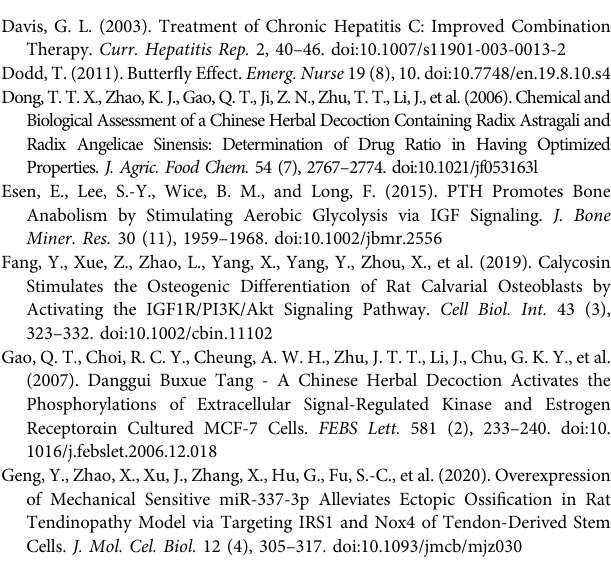
Supplementary Figure 1 | Chemical analysis of DBT and DBT Δ cal. (A): Chemical structure of calycosin. (B): Calycosin at different amount was applied onto osteoblast for 7 days to analyze cell proliferation, ALP activity and pRUNX2-Luc response. These parameters were compared between calycosin and vehicle control. (C) One hundred mg/mL of herbal extract was subjected to analysis, detected at the wavelength 254 nm. The isolated fraction was shown. (D) : ELSD analysis of DBT and DBT Δ cal. Typical HPLC fi ngerprint of DBT and DBT Δ cal were shownhere.Onehundredmg/mLofDBTandDBT Δ cal wasloadedtoHPLCcolumn, and the chemical fi ngerprint was revealed at the ELSD and DAD detector. The isolated fraction was shown. Representative chromatograms were shown, n (cid:2) 4. (E) : Quantitative assessment of 5 major chemicals in DBT and DBT Δ cal. Values are expressed in ng active compound in 1 mg dried extract, in Mean ± SEM, where n (cid:2) 5. *** p < 0.001 as compared with parental DBT. Supplementary Figure 2 | Multivariate analyses of lipidomic. Lipids from treated osteoblast, as in Figure 1 , were subjected to lipidomics analysis by LC-MS in both +ve (left) and -ve (right) modes. A direct comparison between PCA demonstrates that PCA resolves the observation into four clusters. The components PC 1 - 3 are re fl ecting different axis, as